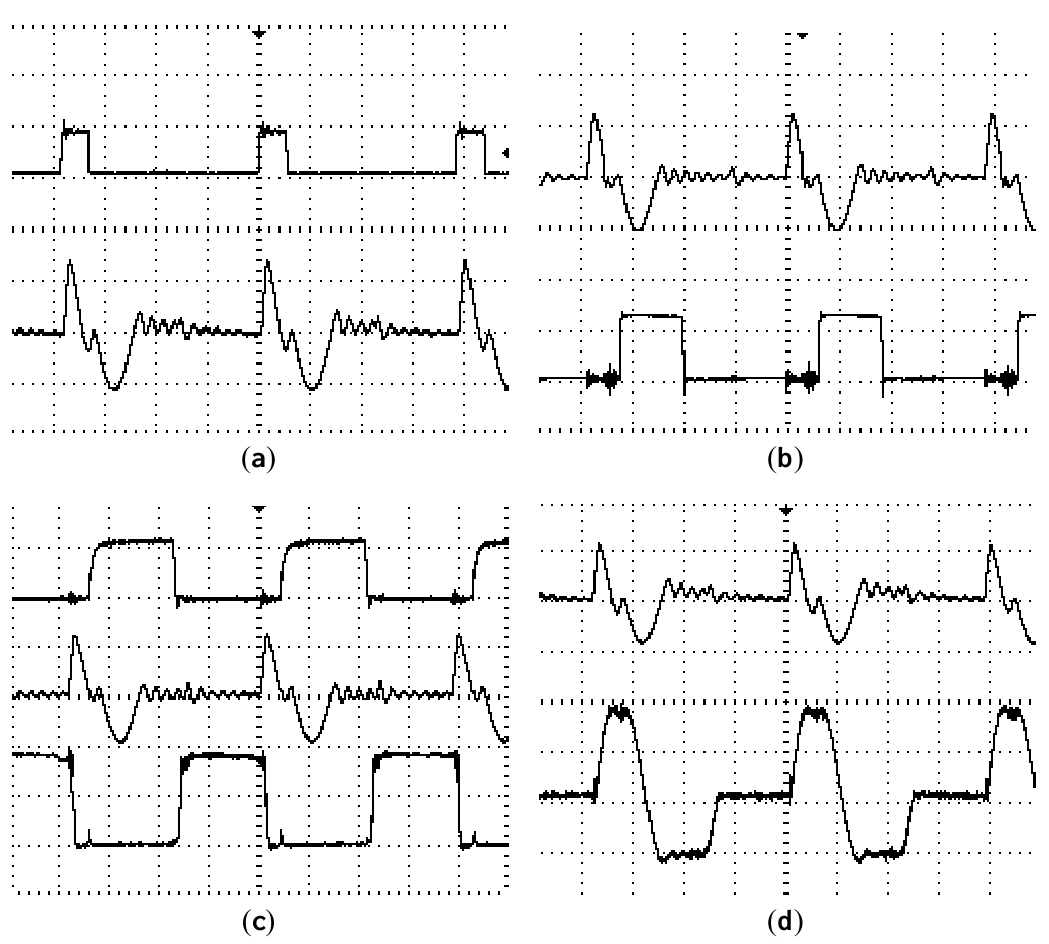
Figure 11. Experimental waveforms. ( a ) Upper Signal: Gating signal V ( V = 20 V/div.) Lower Signal: Current of L Time: t = 2.5 μ s/div. ( b ) Upper Signal: Current of L signal V of S ( V = 10 V/div.) Time: t = 2.5 μ s/div. ( c ) Upper Signal: V GS aux2 switch ( V = 10 V/div.) Middle Signal: Current of L main switch ( V = 200 V/div.) Time: t = 2.5 μ s/div. ( d ) Upper Signal: Current of L